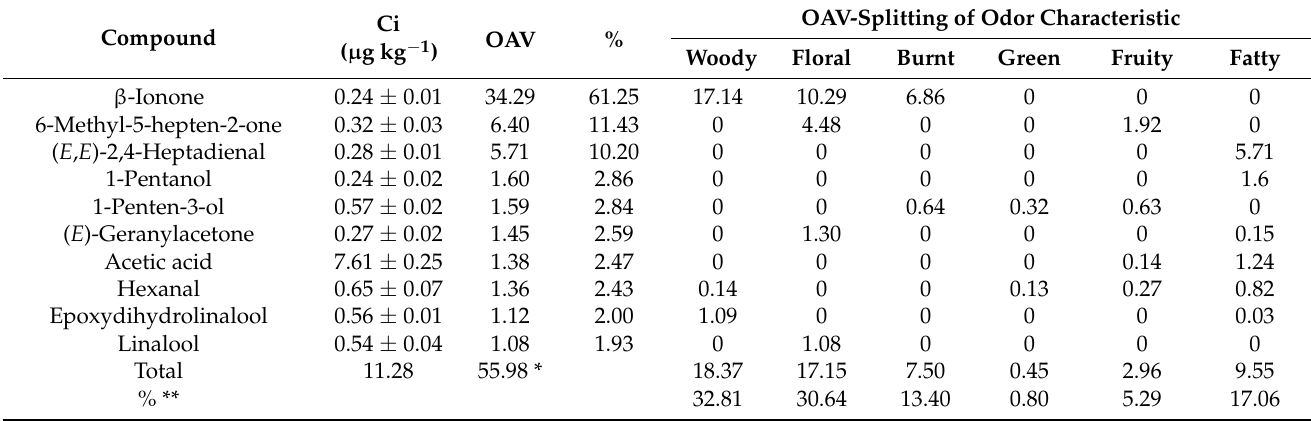
Table 5. The content, OAVi and OAV-splitting of key aroma compounds in dark